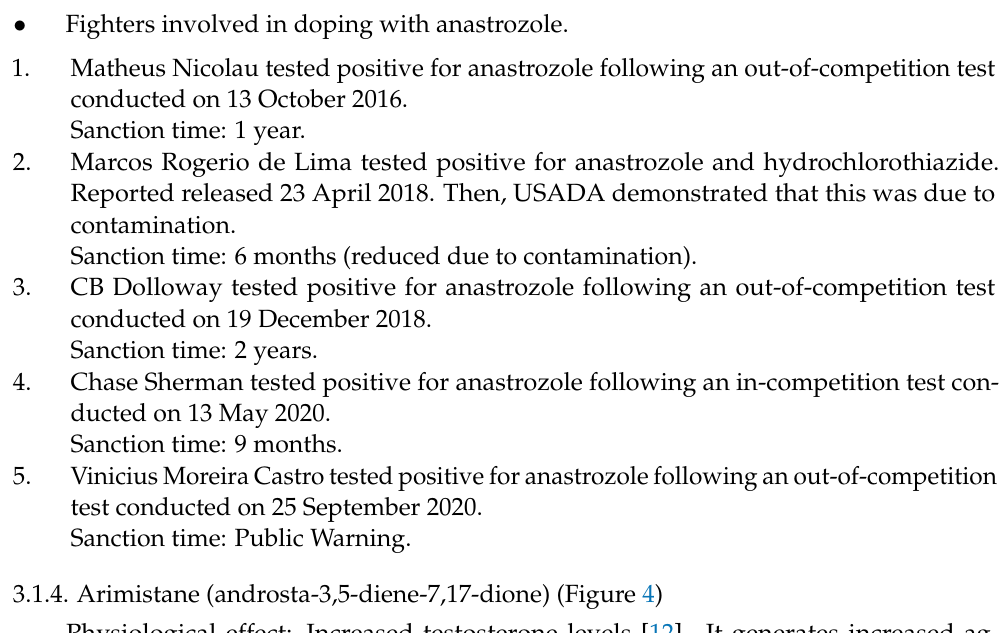
Figure 3. Chemical structure of anastrazole. Formula: C 17 H 19 N 5 .